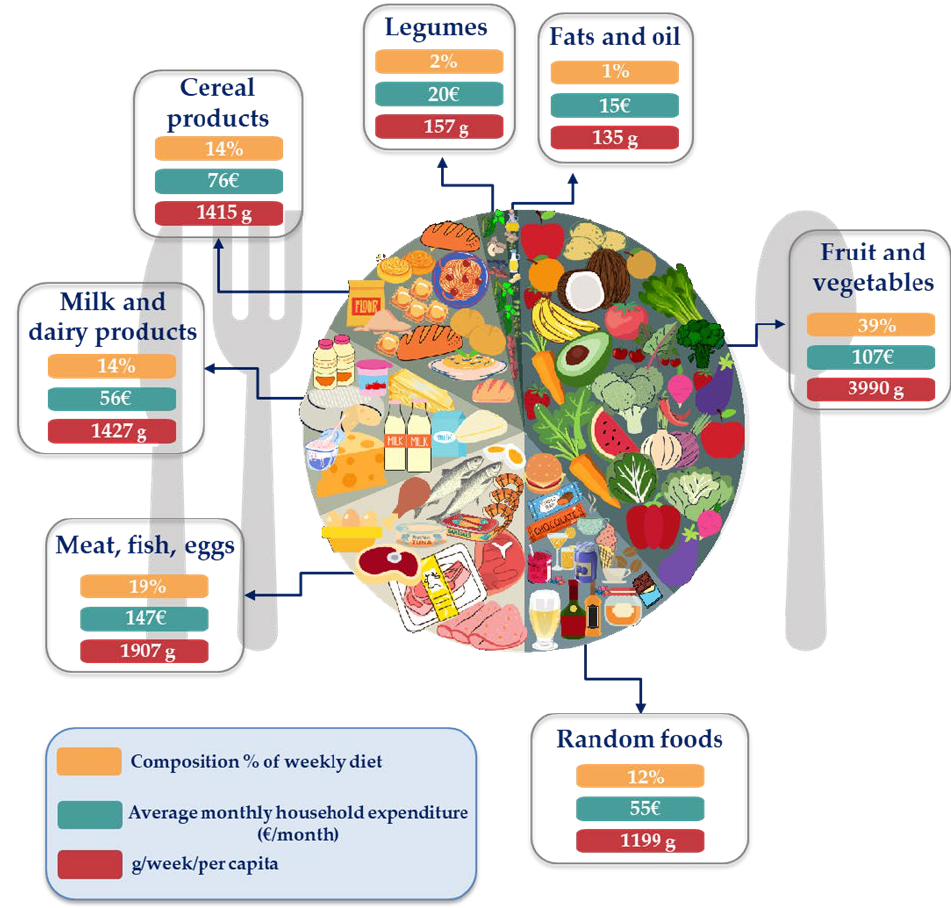
Figure 2. Weekly distribution of foods consumed in Italy (2019) by food groups (ISTAT, 2021). Table 1. Life cycle inventory of Mediterranean diet (MD) and current Italian food patterns (CIFP) in 2019.